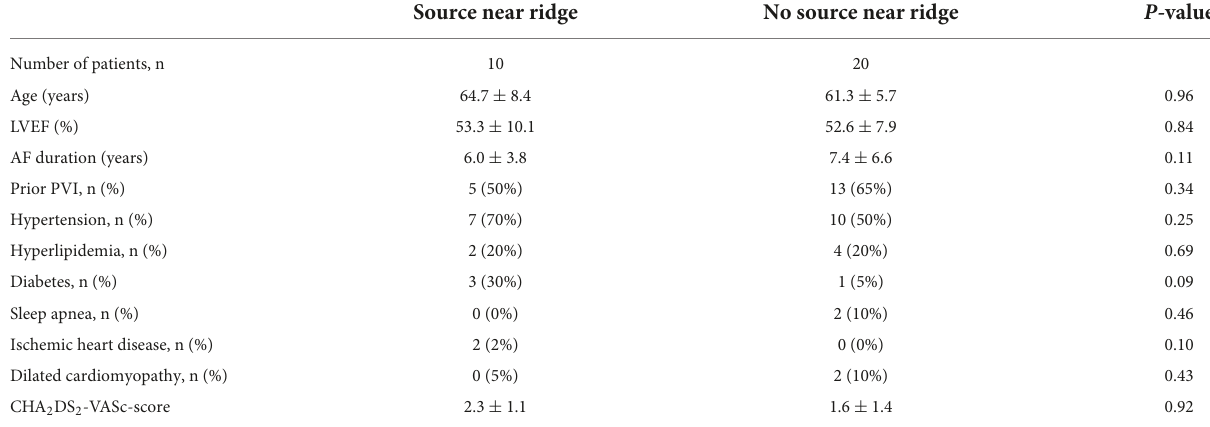
TABLE 1 Demographic and main clinical data.